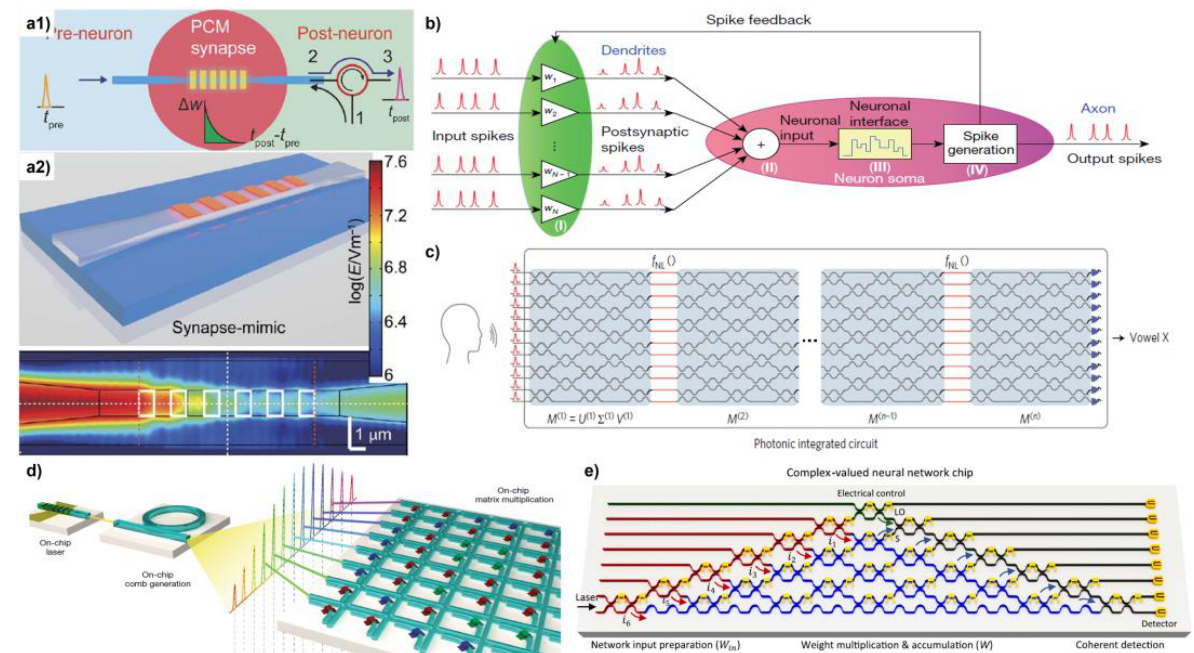
Figure 10. ( a1 ) Schematic of the integrated photonic synapse. ( a2 ) Top: Schematic of the